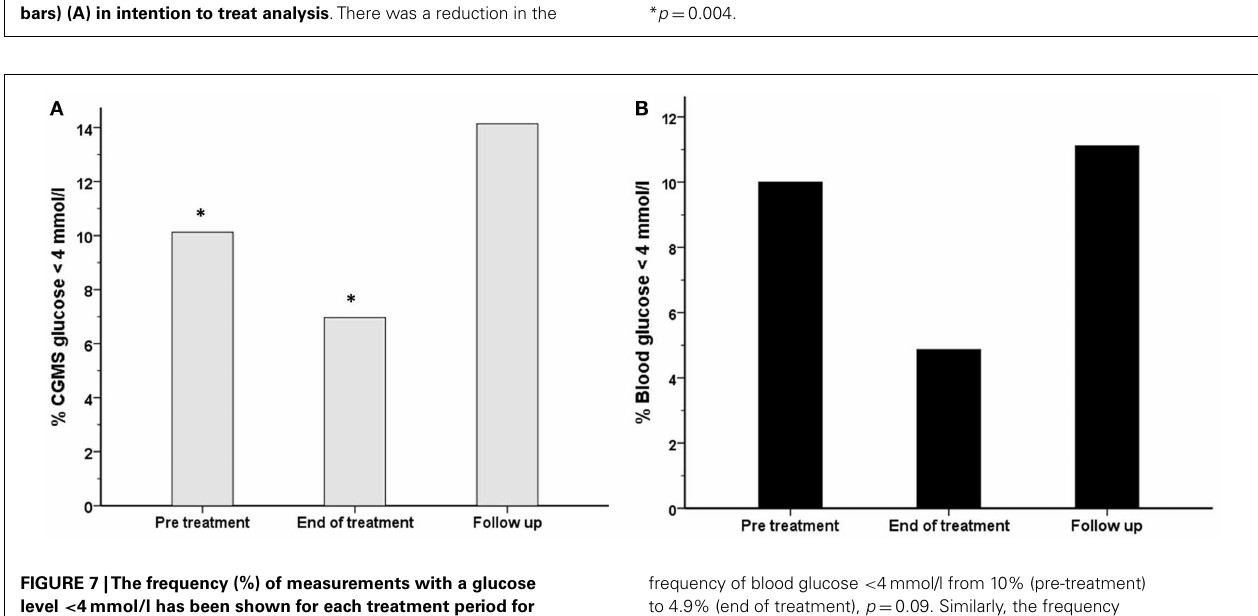
FIGURE 6 |The frequency (%) of measurements with a glucose level > 10mmol/l has been shown for each treatment period for both blood glucose (black filled bars) (B) and CGMS glucose (gray bars) (A) in intention to treat analysis .There was a reduction in the